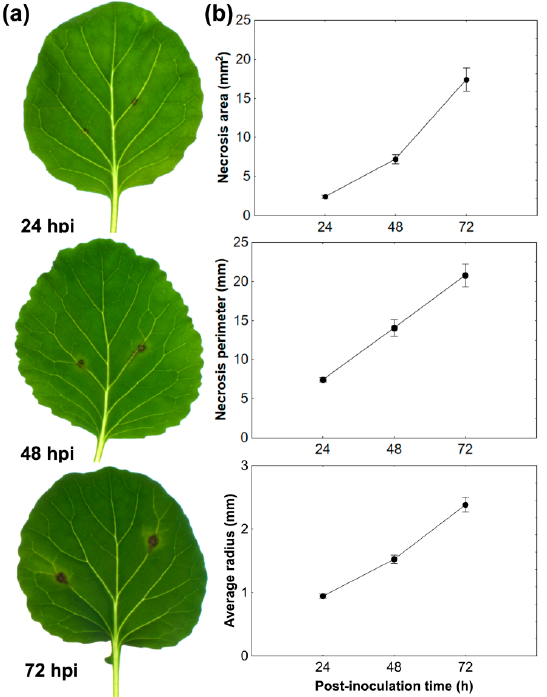
Figure 1. Analyses of necrotic lesion development on the second fully developed leaf of B. oleracea infected with A. brassicicola : ( a ) time-course images of necrosis development on the drop-inoculated leaves; ( b ) quantitative analysis of necrotic spot size changes. Data were gained using the WinDIAS system. The means ± SE were calculated from at least 18 measurements per time point obtained in 3 independent experiments ( n = 3).